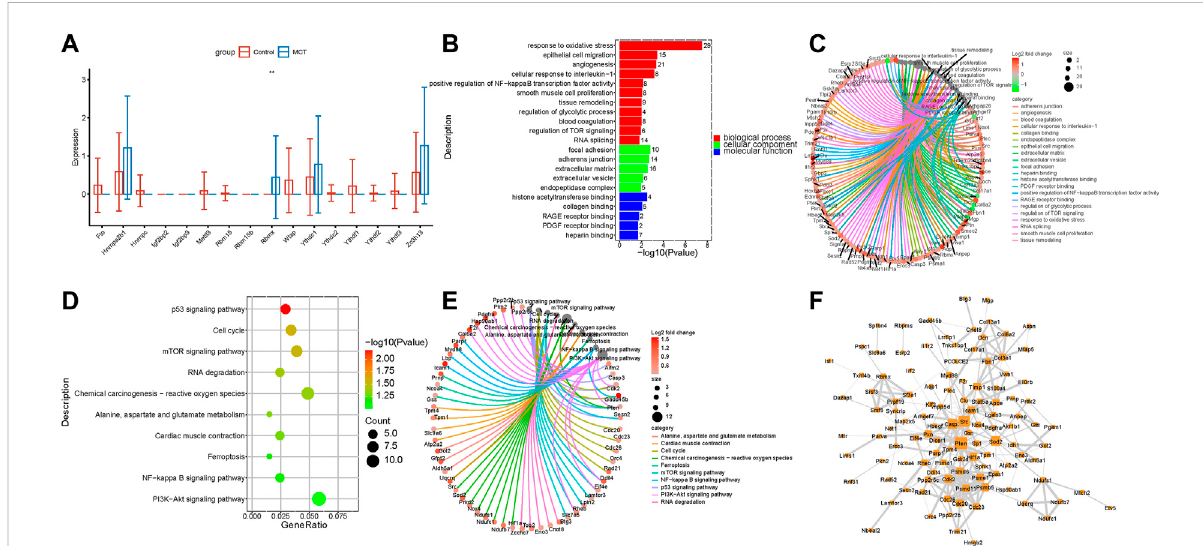
FIGURE 4 TheexpressionofN6-Methyladenosineregulatorswasdysregulatedin fi broblasts. (A) RBMXexpressionwasincreasedinthe fi broblasts. (B) The GO analysis of the target genes of RBMX that overlapped with the upregulated DEGs. (C) The genes involved in the enriched pathways are depicted. (D) The KEGG analysis of the target genes of RBMX overlapped with the upregulated DEGs. (E) The genes involved in the enriched pathways are depicted. (F) The hub networks constructed based on the genes depicted